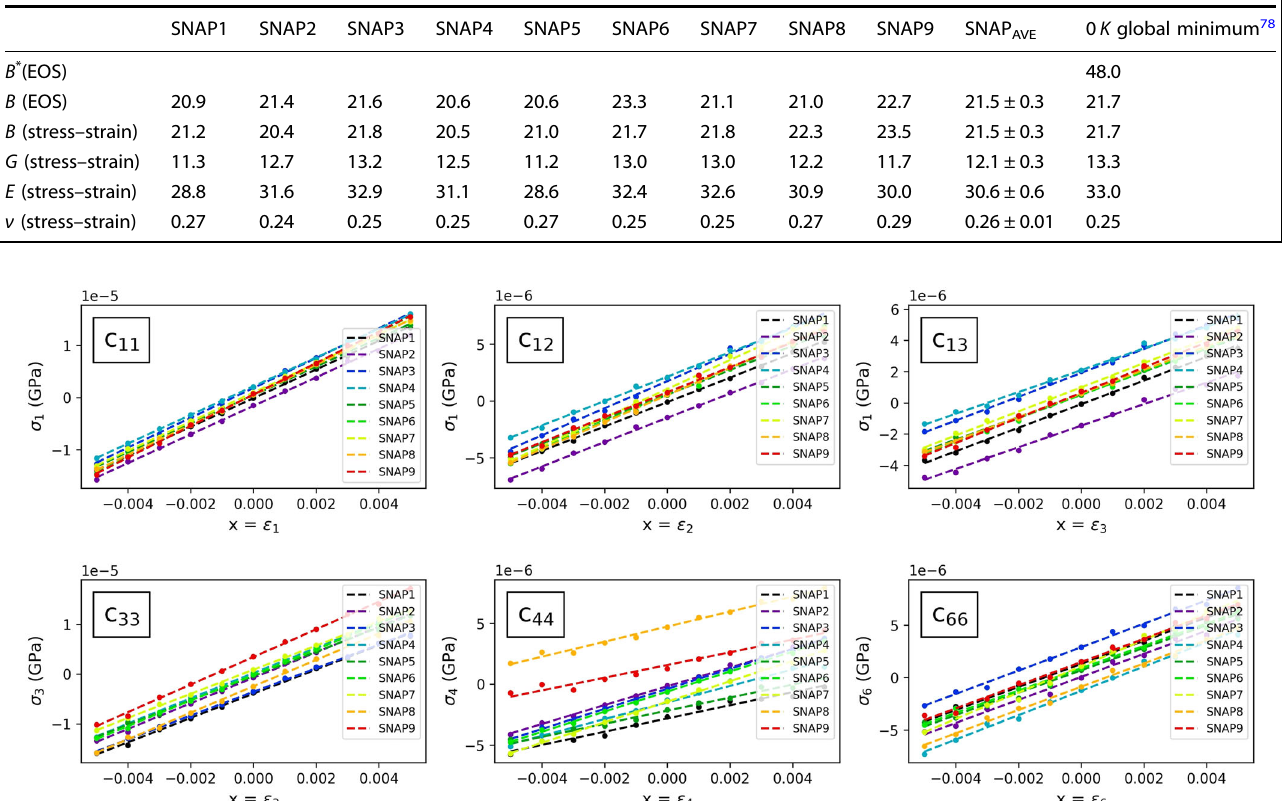
Table 4. B , G , E (in GPa), and ν from the static methods (EOS and stress – strain) applied to nine uncorrelated snapshots, fully relaxed, from the t-LGPS NPT -600 K CP molecular dynamics (with the standard errors of the mean), and to the global minimum energy structure 78 , fully relaxed.